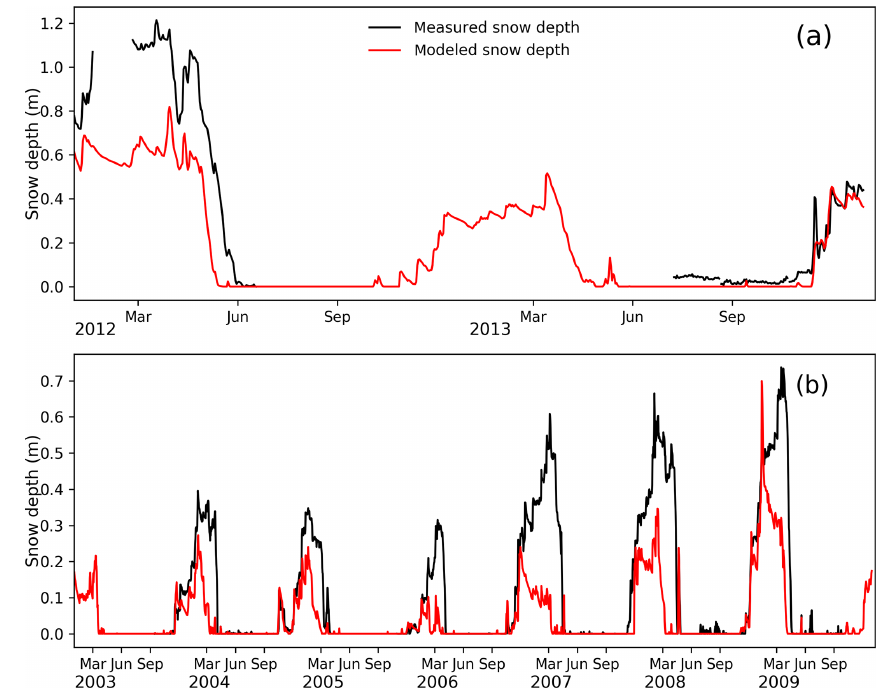
Figure 9. Simulated vs. measured snow depth (m) at the (a) DK-NuF and (b) CA-Wp1 fen